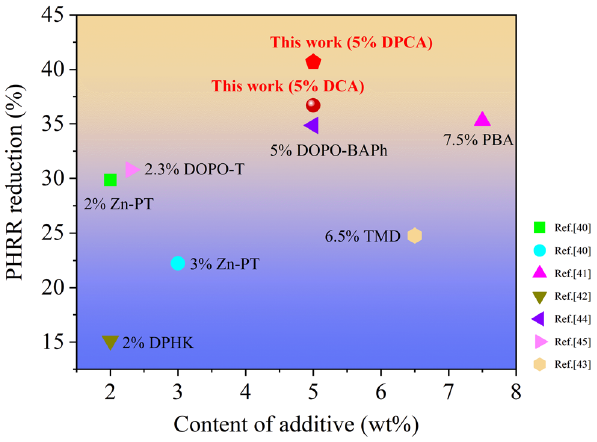
Figure 6: Comparison of PHRR reduction with previous literature.